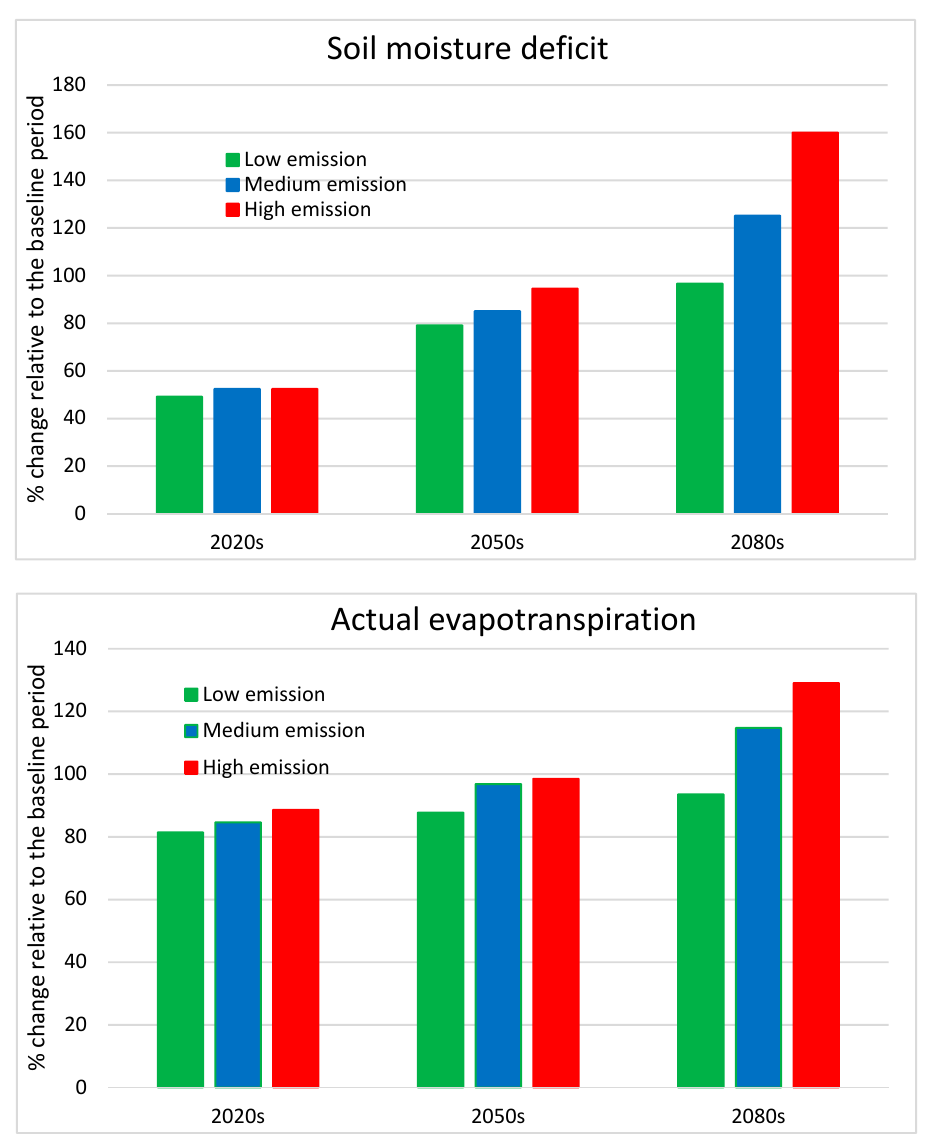
Figure 13. Soil moisture deficit ( top ) and actual evapotranspiration ( bottom ) projected under different climate change scenarios using UKCP09 weather generator data.